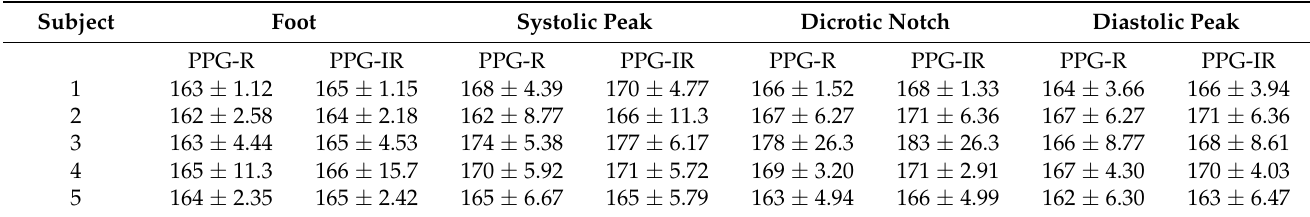
Table 2. Mean and SD of time delays (in milliseconds) between PW fiducial markers of FCG and PPG.